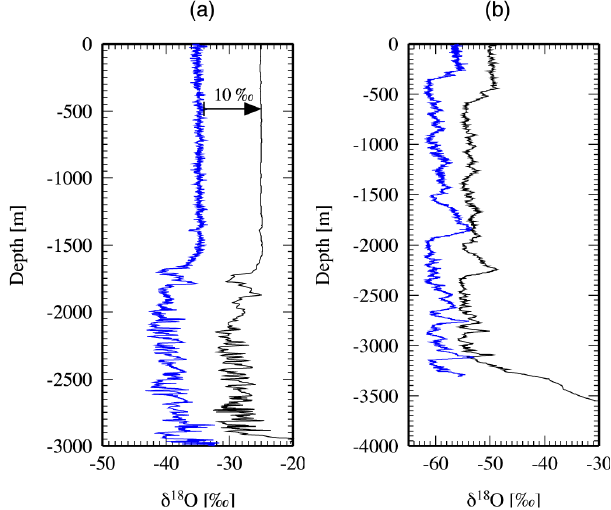
Figure 15. Comparison of modelled δ 18 O values in black and ob- served values in blue. The modelled data in the GRIP core (a) have an offset of 10 per mille to the right in order to make the comparison more easy to read. The vertical axis is the ice core depth and level 0 is defined as the ice surface in both, measured and modelled ice core. For the GRIP core (a) the modelled depth is 2945 compared to observed 3029m with reliable δ 18 O data until 2983.2m, and for the Vostok core (b) the modelled depth is 3549m compared to 3623m in reality and data are available until